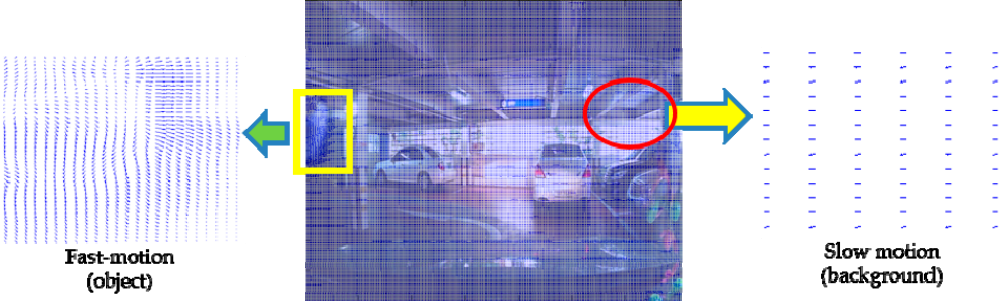
Figure 2. Optical flow between two consecutive frames. In this result, the vectors representing background motions stay consistent while moving object region shows major changes.